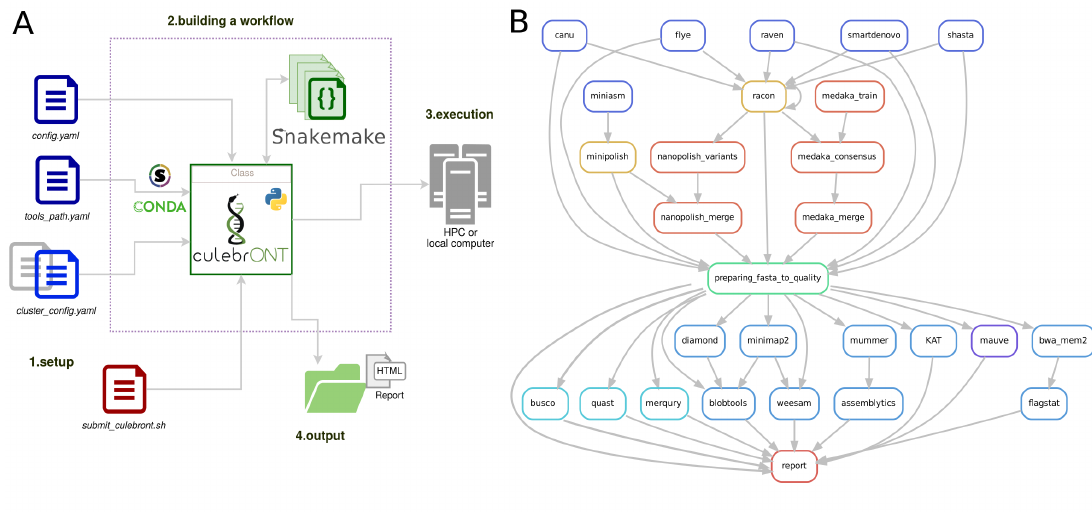
Figure 1 – A graphical overview of the CulebrONT pipeline features. A . A concep- tual diagram of the various tasks involved in setting up a custom CulebrONT work- flow: setting up workflow steps and parameters, executing and viewing results of Cule- brONT. (1) workflow steps and parameters are provided by the user in the config.yaml , tools_path.yaml and cluster_config.yaml files. (2) CulebrONT python class reads, trans- forms and chains rules to build the corresponding pipeline. (3) Rule execution can be performed sequentially or in parallel, on a single machine or a HPC infrastructure, with concurrent jobs and multi threaded tasks. (4) The results of individual steps are aggre- gated in a convenient HTML output report. B . Simplified diagrams showing the compo- nents of an example CulebrONT workflow for assembling a linear genome. In the upper part, the tools used for assembly (blue shape outline) and polishing/correction (yellow and red shape outline) are connected with arrows following the directional flow of the pipeline. In the central part, the various versions of the assembled genomes are gathered ( preparing_fasta_to_quality ) to serve as input for subsequent quality evaluation tools in the lower part. Ultimately, the output is aggregated in a final